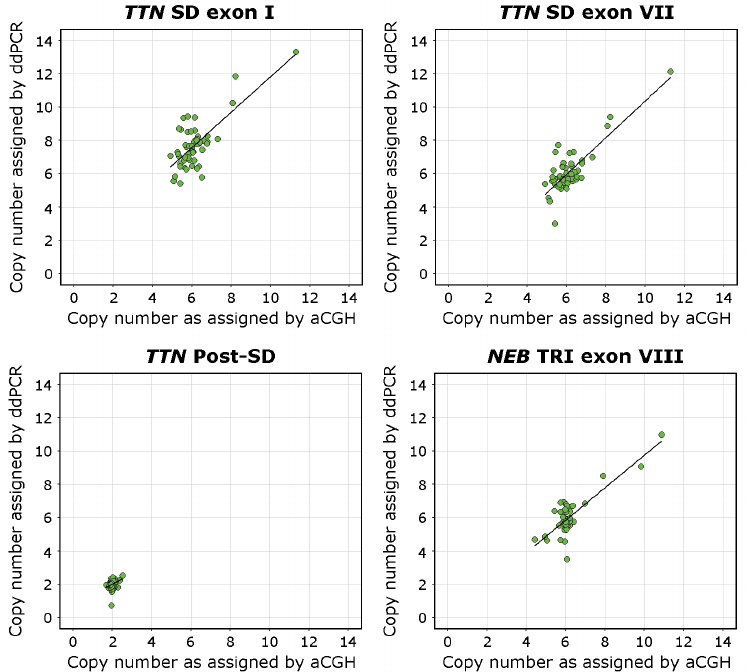
Figure 3. Scatterplots visualising the CN of the TTN SD exons I and VII, the TTN Post-SD target sequence, and NEB TRI exon VIII in relation to the CNs estimated using the NMD-CGH-array with corresponding linear regression trend lines. The aCGH CN estimate for the TTN Post-SD assay is derived from the calculated CN of the TTN backbone. The deviation from the 1-to-1 ratio between the NMD-CGH-array derived and TTN SD exon I assay derived CN estimates is consistent with the fact that the CN of exons I and II of the TTN SD is higher than than the average CN of the entire repeated block, which the NMD-CGH array cannot detect due to methodological